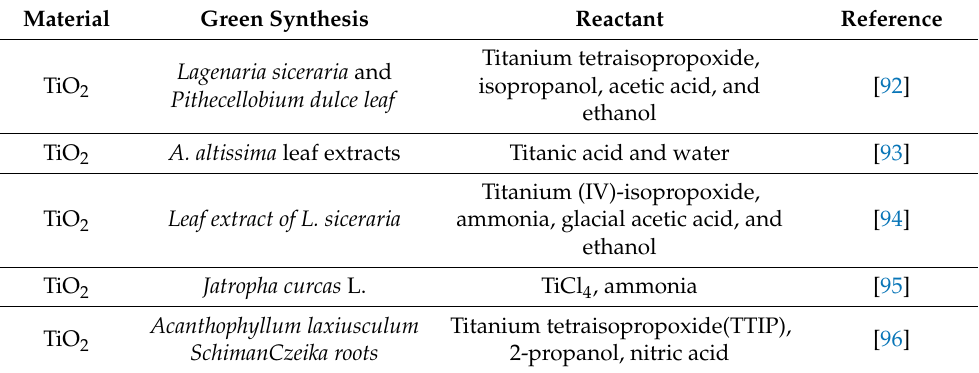
Table 3. Green sol-gel synthesis approach for the preparation of TiO 2 nanostructures.